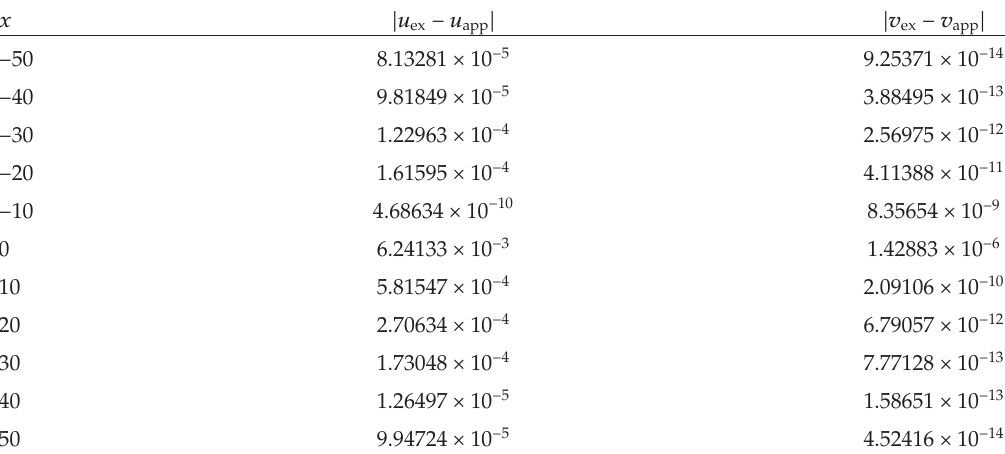
Table 4: The approximate solutions (cid:2) 5.27 (cid:3) and (cid:2) 5.28 (cid:3) in comparison with the exact solutions (cid:2) 5.22 (cid:3) and (cid:2) 5.23 (cid:3) , respectively, if t (cid:7) 0 . 5, k (cid:7) 0 . 1 , c (cid:7) 0 . 2 , ξ